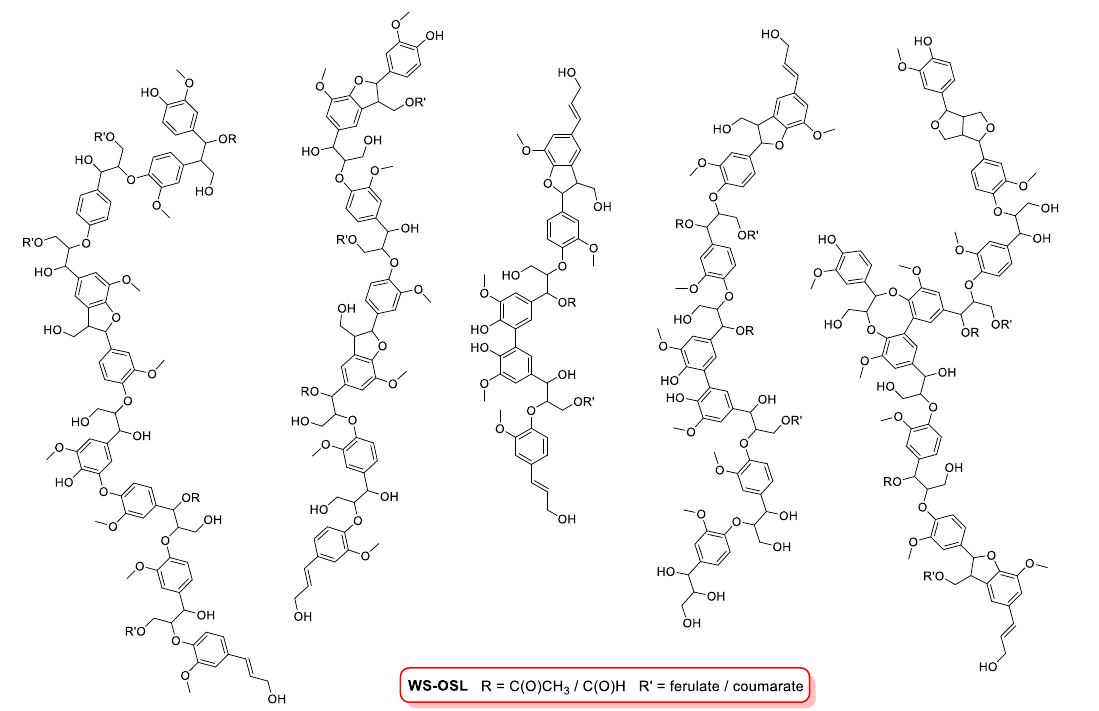
Figure 1. Structural features of organosolv lignins WS-OSL .